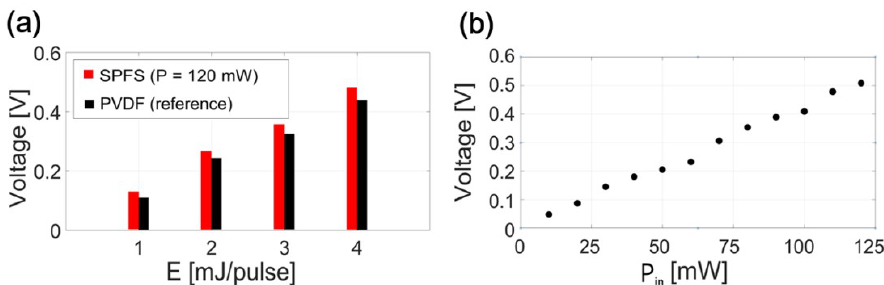
Figure 5. ( a ) Comparison of ultrasound signal amplitudes measured by SPFS and polyvinylidene difluoride (PVDF) hydrophone for the CNT-PDMS transmitter excited by E = 1, 2, 3 and 4 mJ/pulse); ( b ) SPFS peak signal values versus the probe laser beam power P in (CNT-PDMS transmitter excited by E = 4 mJ/pulse).